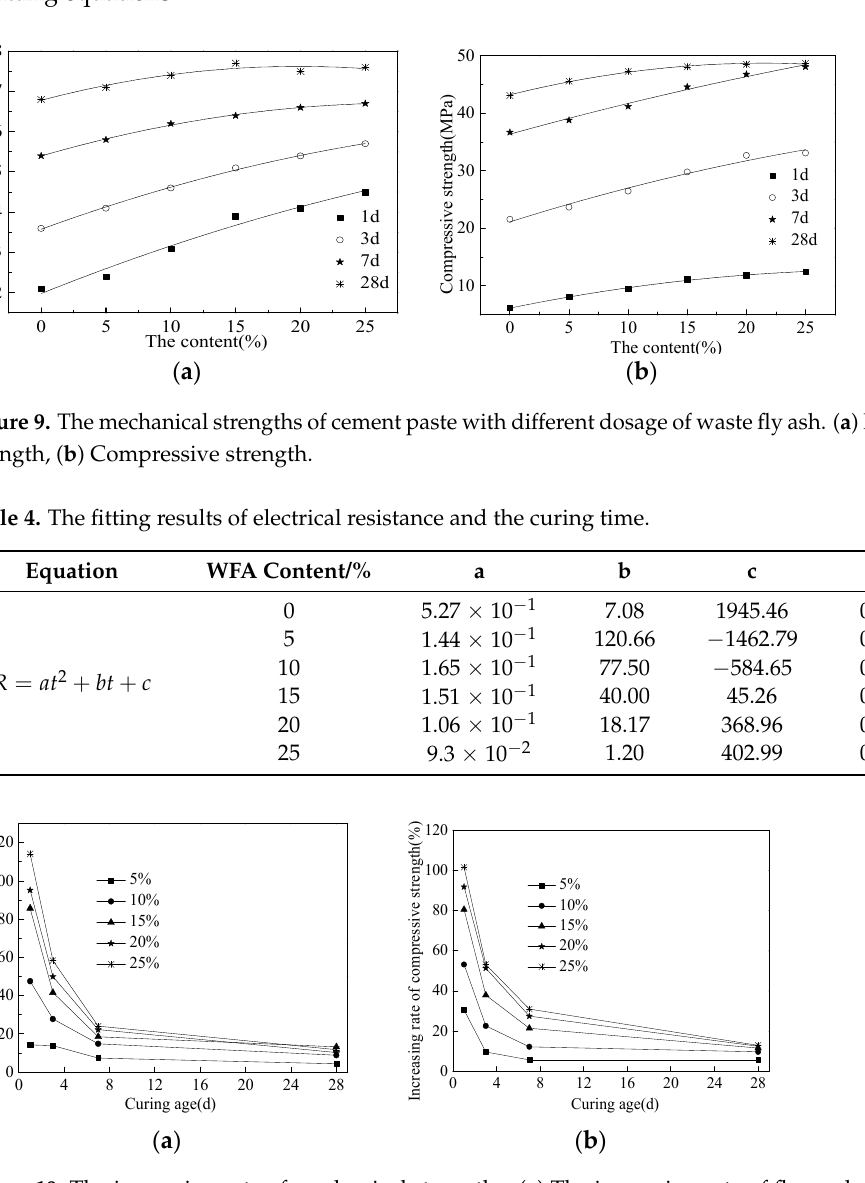
Table 4. The fitting results of electrical resistance and the curing time.